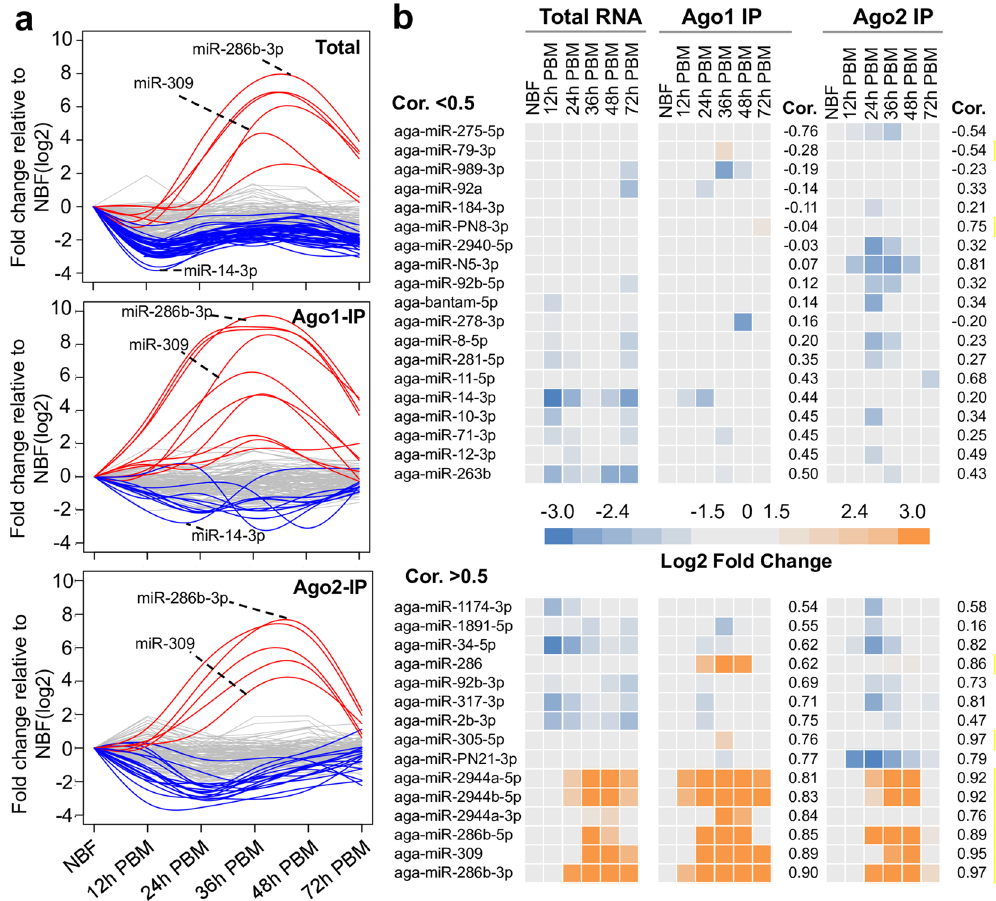
Figure 4. Expression and Ago integration of miRNAs after blood feeding in An . gambiae . ( a ) Changes in miRNA levels after blood feeding in terms of total small RNA, Ago1-IP RNA and Ago2-IP RNA. Each line represents one miRNA at six time points. Lines in red: upregulated miRNAs; lines in blue: downregulated miRNAs; lines in gray: miRNAs with no significant change. ( b ) Heatmap shows the log2-fold changes in miRNAs relative to the non-blood-fed controls. A Pearson correlation analysis were performed to assess the relationship between miRNA abundance in the total small RNA and in the Ago-IP RNA. Cor., Pearson correlation